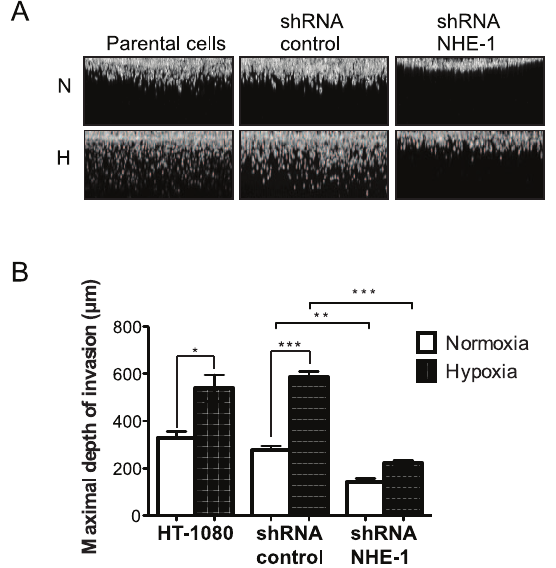
Figure 4. NHE-1 is involved in hypoxia-induced cell invasion. HT-1080 cells transfected with NHE-1 shRNA or control (scrambled) shRNA were allowed to invade collagen gels for 24 h under normoxia or hypoxia and stained with calcein-AM. (A) Representative confocal images showing the relative fluorescence intensity of the cells according to the depth of migration. (B) Graph represents maximal depth of invasion (n=3). Columns represent the mean 6 SEM indicated by the horizontal bars. The asterisks correspond to, * p , 0.01; ** p , 0.001; *** p , 0.0001.